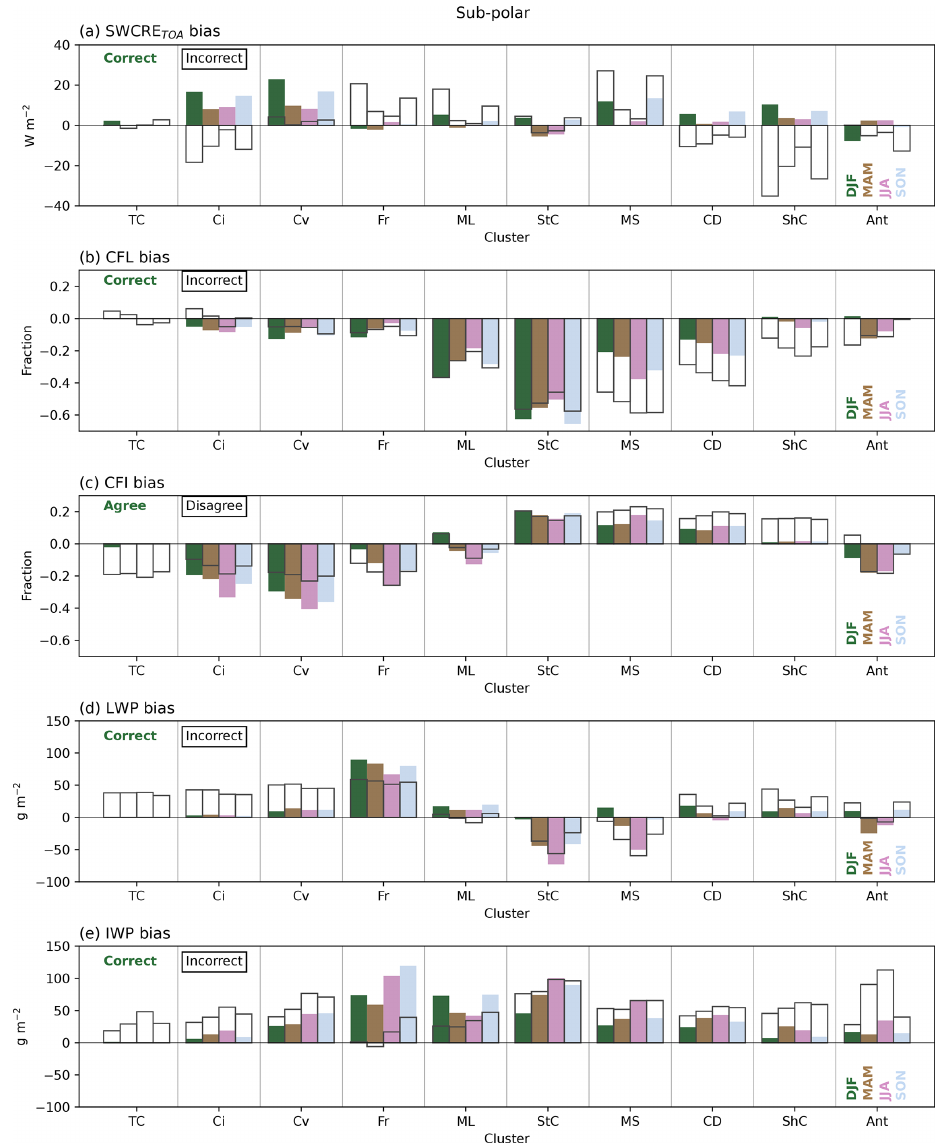
Figure 9. The same as Fig. 8 but for the sub-polar